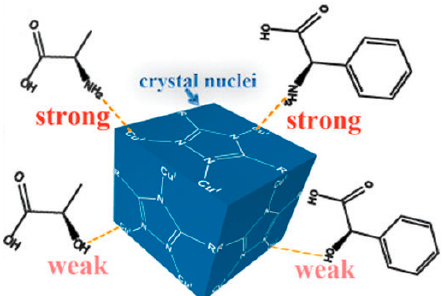
Figure 10. The plausible mechanism of the chiral induction effect. Reproduced from [87] with permission from the Royal Society of Chemistry.